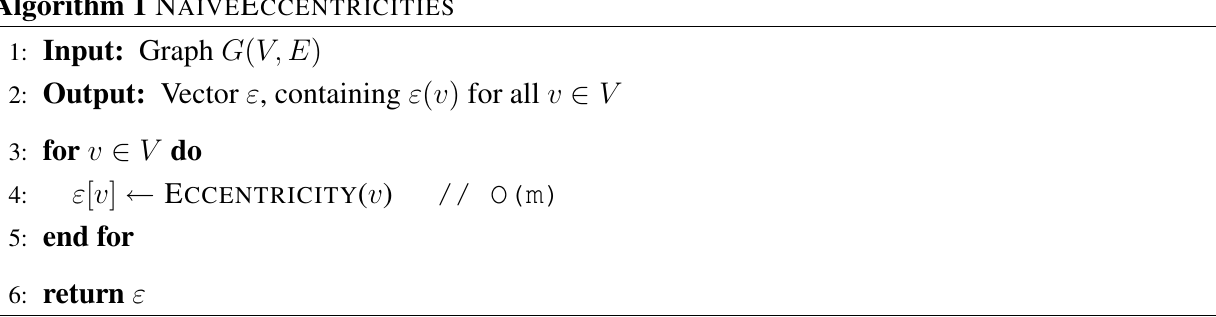
Algorithm 1 N AIVE E